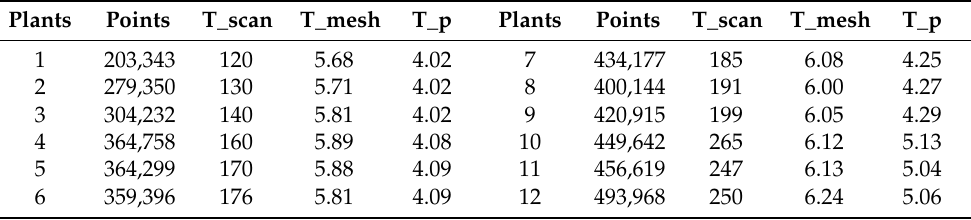
Table 6. Time cost (second). T_scan: time of data scanning. T_mesh: time of 3D model output. T_p: time of data